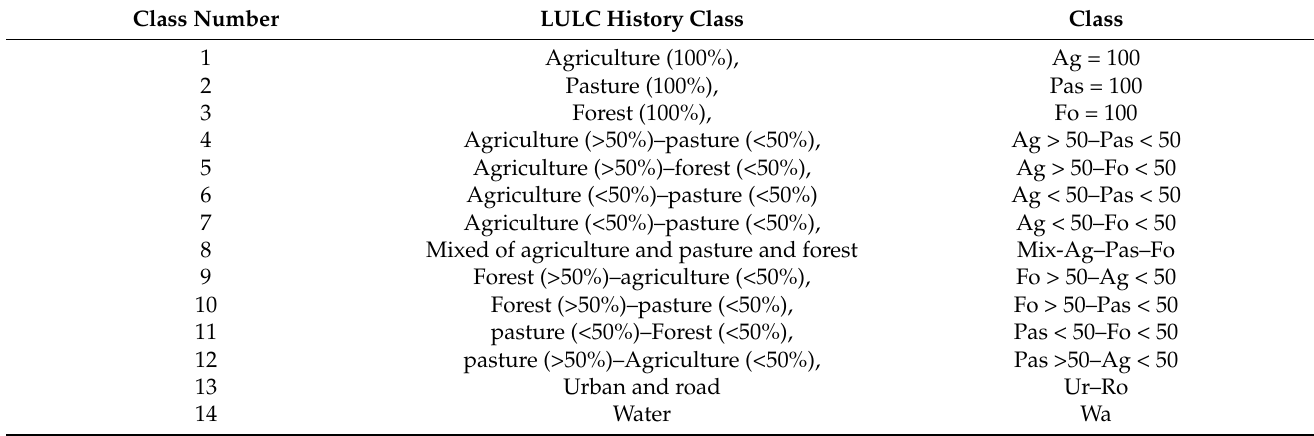
Table 1. LULC history classes during 1985 to